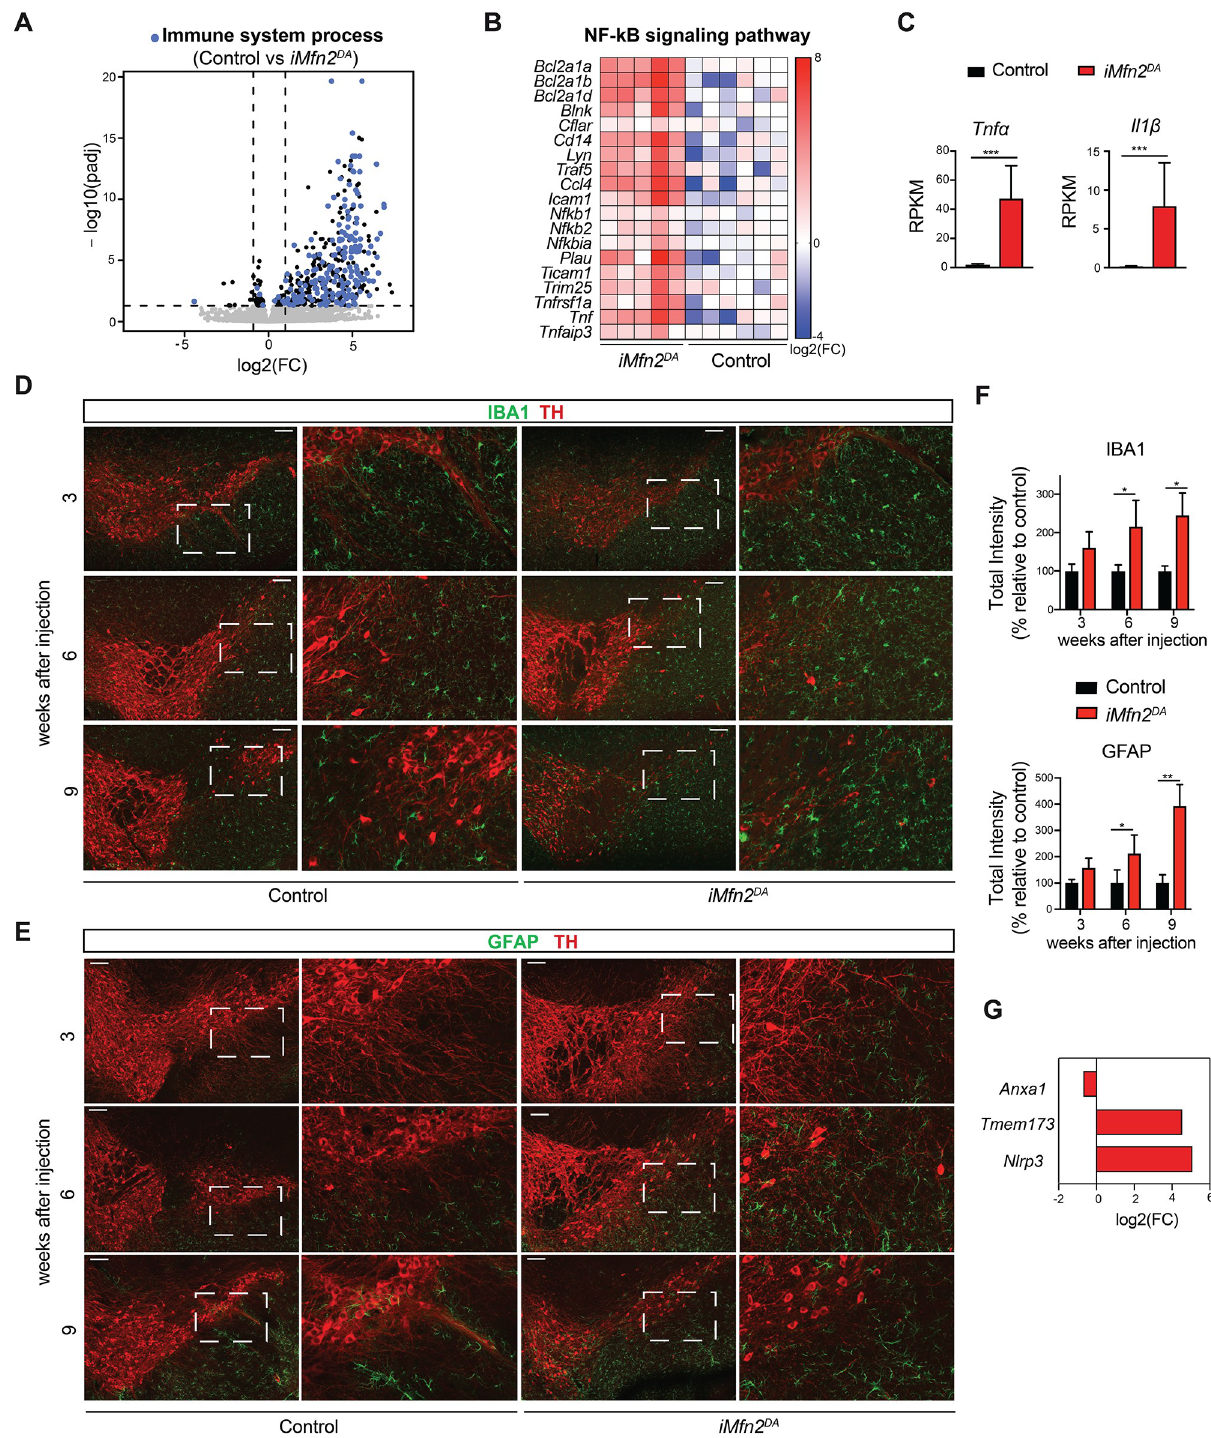
Fig 5. Activation of glial cells surrounding DA neurons in in tamoxifen-injected iMfn2 DA mice. (A) Volcano plot displaying differential gene expression in iMfn2 DA FACS-sorted DA neurons: the 439 differentially expressed genes are represented in black and blue. The genes involved in the immune response are represented in blue. (B) Heatmap showing the gene expression of NF-kB signaling pathway in DA neurons isolated from iMfn2 DA and control mice. (C) RNA expression levels (RPKM) of the inflammation markers Tnf- α and IL1 β in mitoYFP+ cells from iMfn2 DA and control mice. Data are shown as mean ± SD. (D-E). Representative confocal microscopy image of control and iMfn2 DA mouse brains at 3, 6, and 9 weeks after injection. DA neurons were labelled with an antibody against TH (red) and the brain sections were additionally labelled with antibody